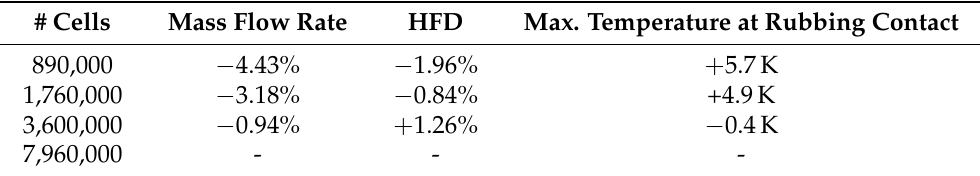
Table 1. The results of mesh independence study #